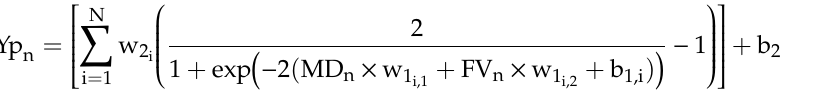
Figure 4. Typical schematic structure for the developed ANN models for predicting the rheological properties of HBM.